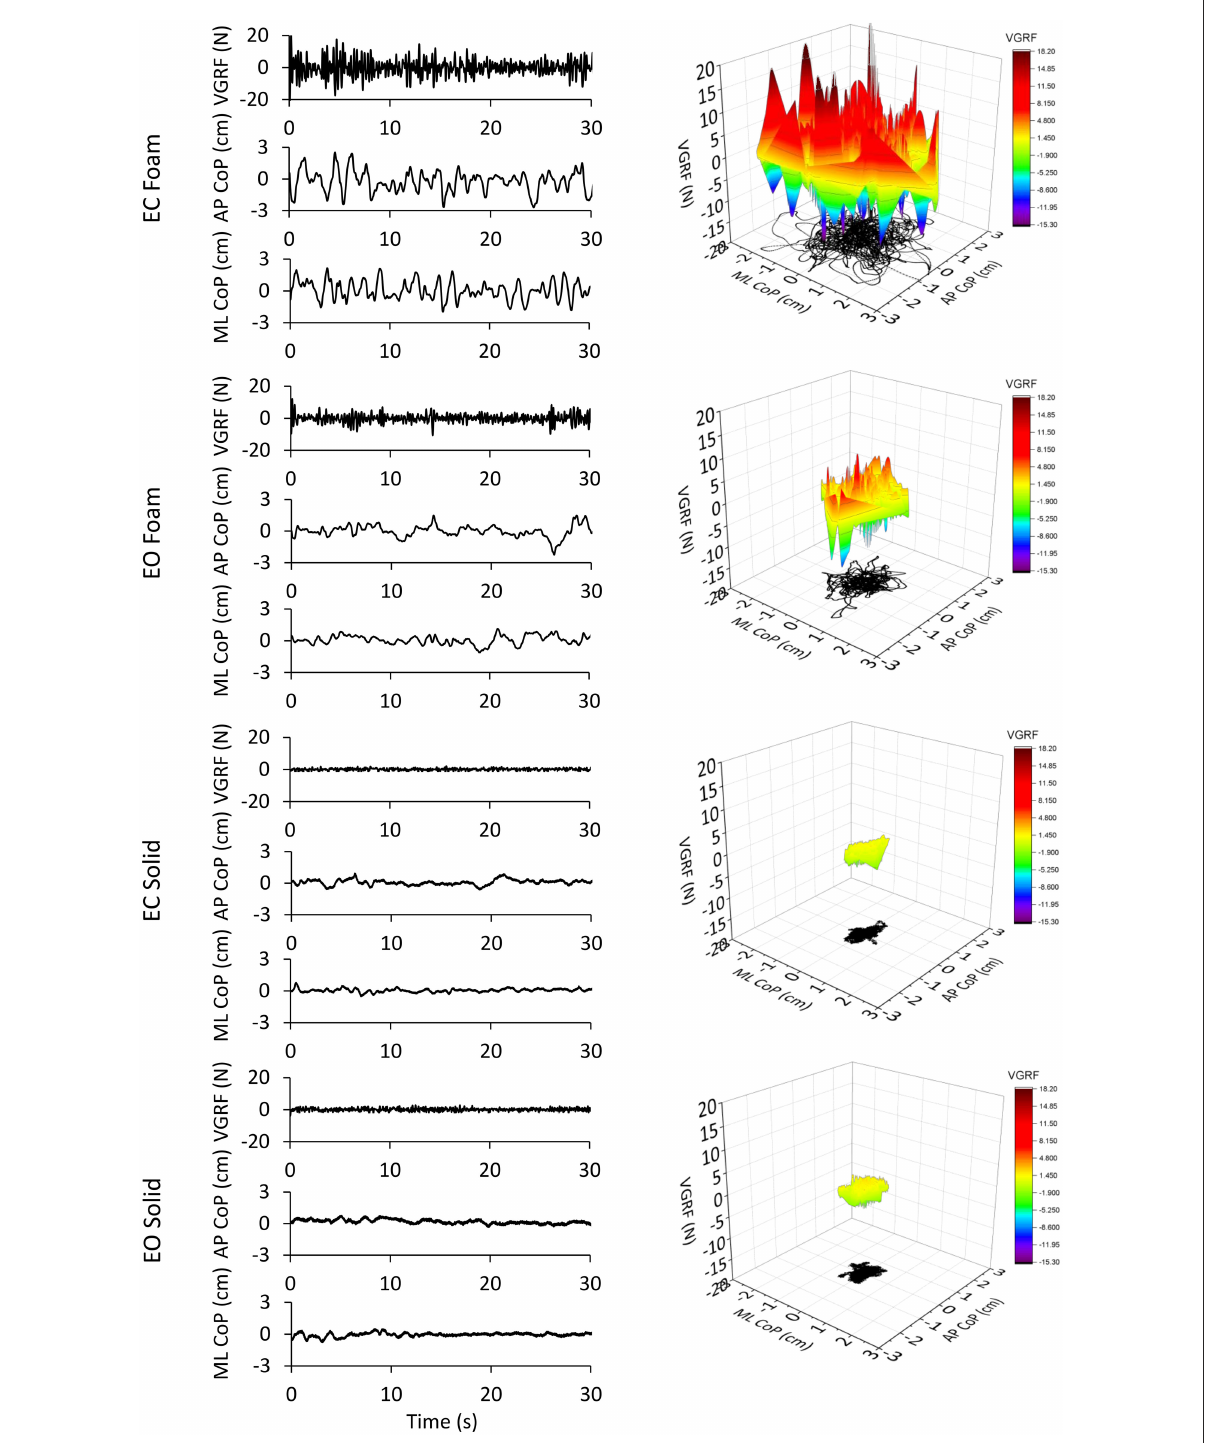
FIGURE1 VGRF variations and CoP displacement in a representative subject. In the left column are reported the VGRF oscillations around the mean value (i.e., the subject’s weight) and the CoP oscillations around the mean position for both ML and AP directions in the four different experimental conditions (eyes closed, EC or eyes open, EO) with Foam base of support and EC or EO with Solid base of support). Only the first 30s of the 90s acquisition epochs are shown. In the right side of the Figure, the VGRF oscillations are plotted against the CoP displacements on the horizontal plane in the four conditions of interest. VGRF oscillations and CoP displacements were the greatest in the EC Foam condition. With EO Foam, VGRF oscillations and CoP displacements diminished and became the smallest with Solid base of support where vision had little